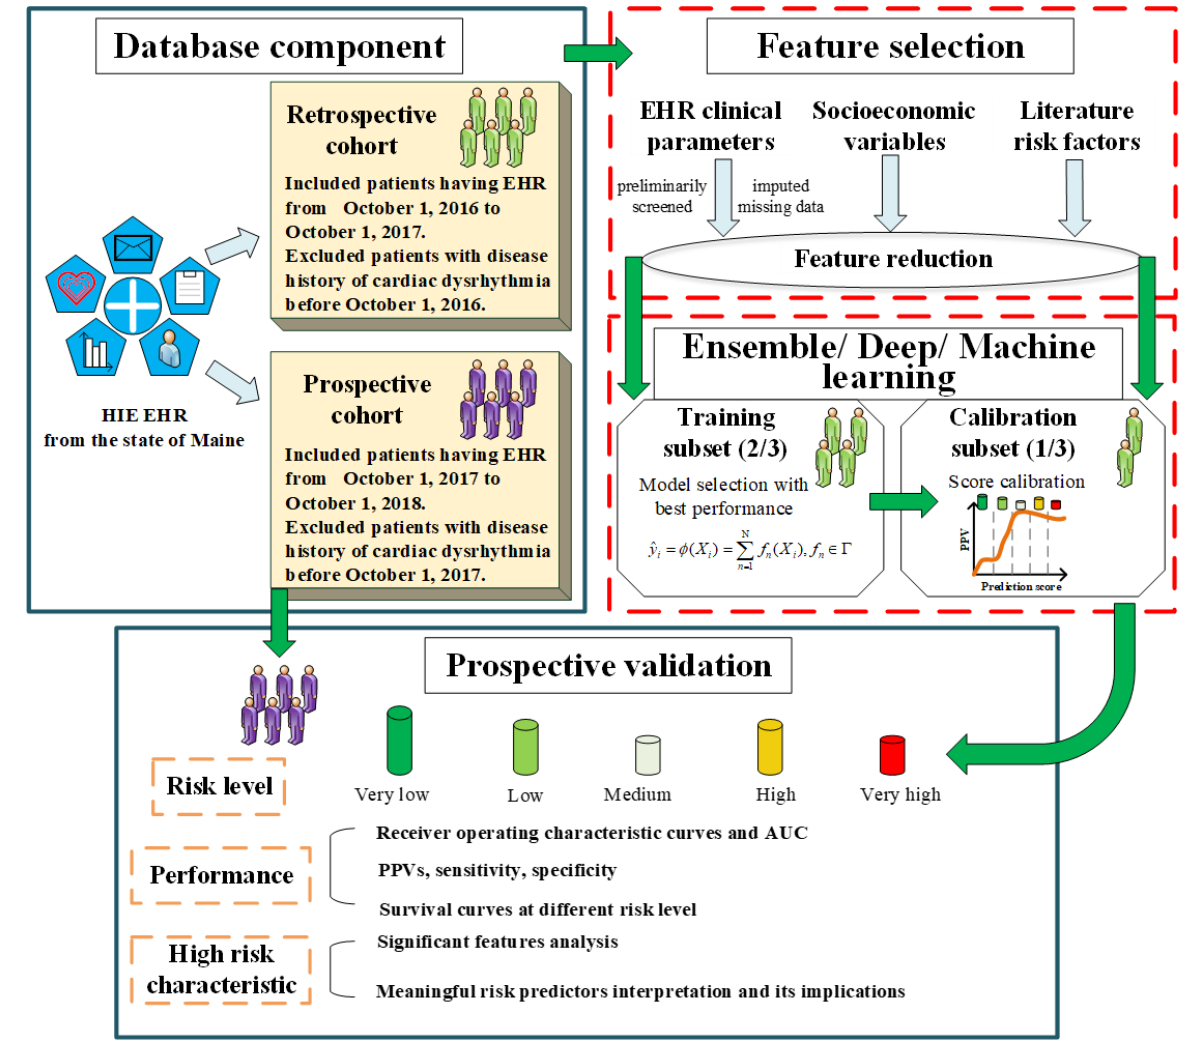
Figure 1. A workflow diagram that describes data collection, data classification, model building, and model evaluation. AUC: area under the curve; EHR: electronic health record; HIE: health information exchange; PPV: positive predictive